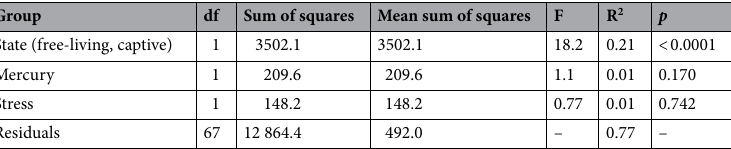
Group df Sum of squares Mean sum of squares F